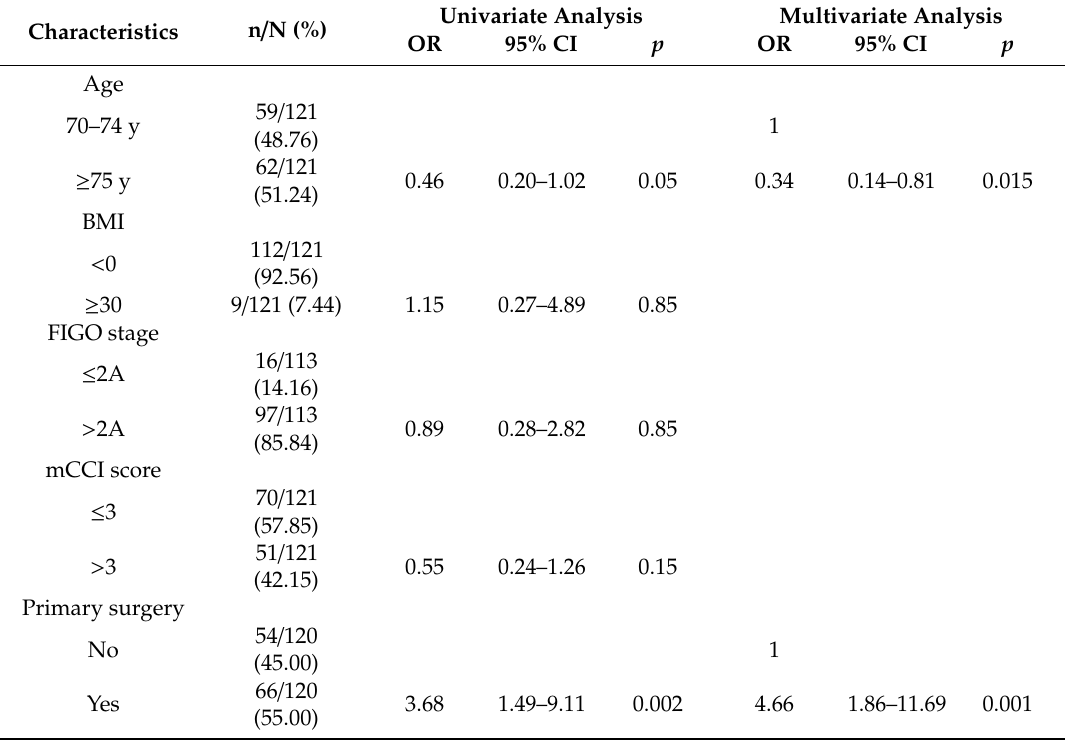
Table A4. Univariate and multivariate analysis of probability of postoperative complications.